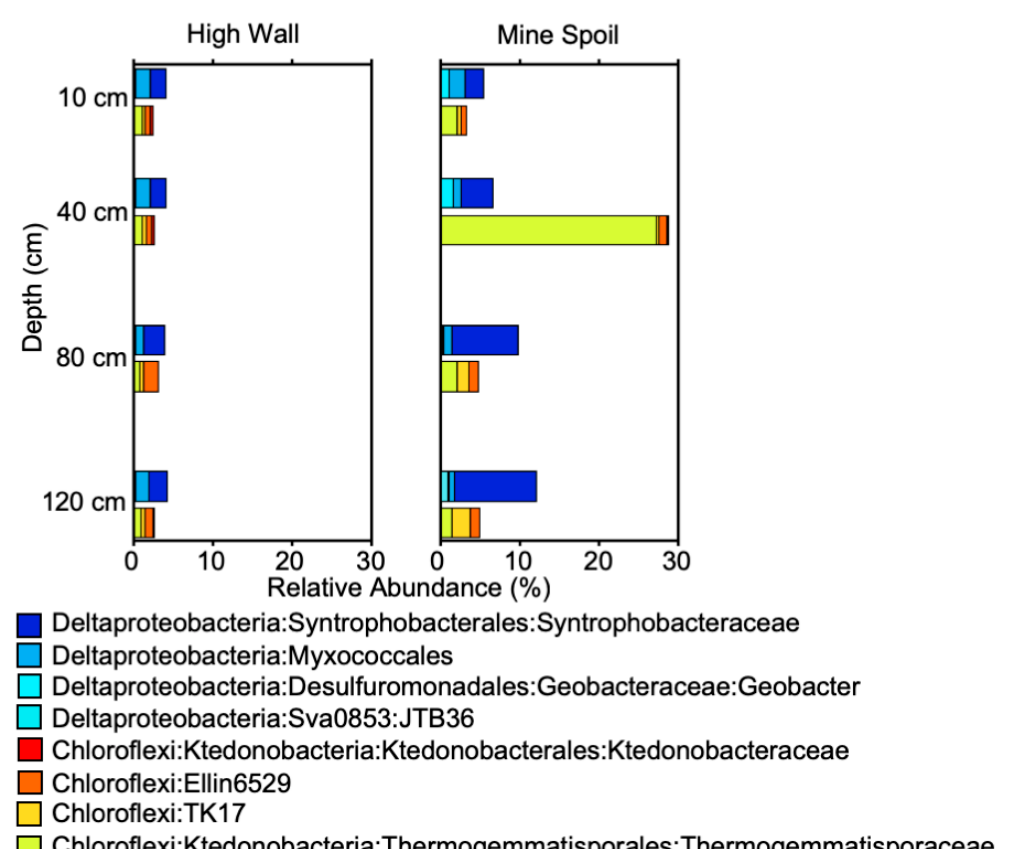
Figure 9. Relative abundances of Deltaproteobacteria (cool colors) and Chloroflexi (warm columns) at varying depths in high wall and mine tailings. The key on the bottom of the panel indicates the highest-resolution taxonomic assignments of the most abundant phylotypes within the Deltaproteobacteria and Chloroflexi.